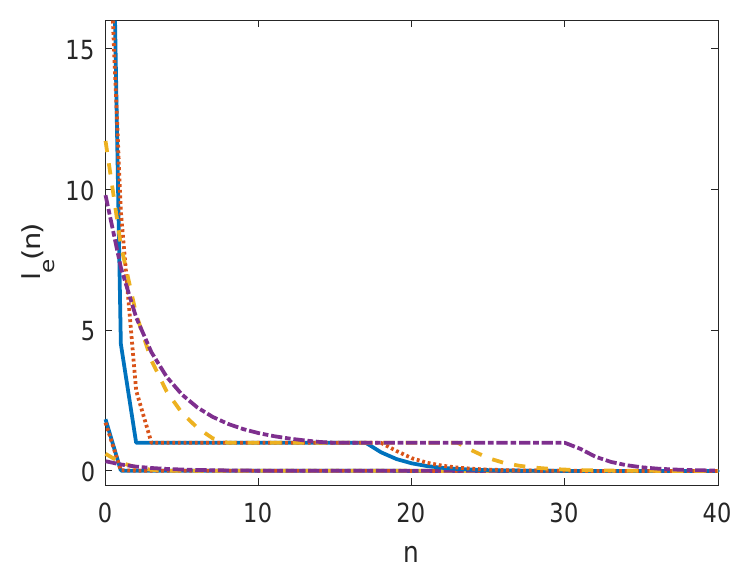
Figure 6. Closed-loop economic performance of EMPC of Equation (10) with modified zone Z (cid:48) Equation (24), with c 1 = 10 4 and c 2 = 10 2 (solid), c 2 = 10 3 (dotted), c 2 = 10 4 (dashed), c 2 = 10 5 (dash dotted), respectively. The upper and lower part correspond to initial state x ( 0 ) = 5 and x ( 0 ) = − 5, respectively.